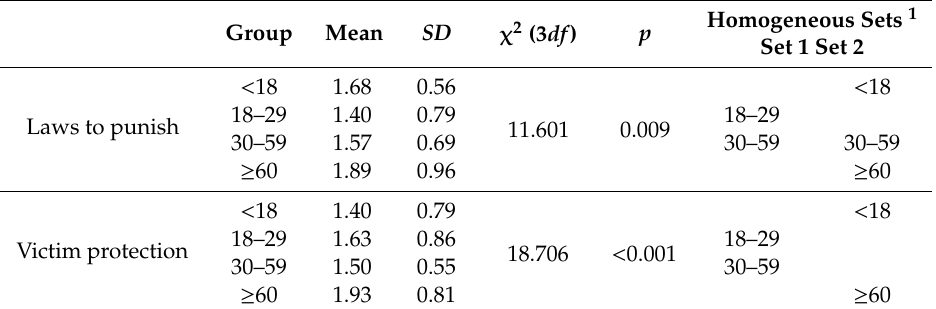
Table 7. Perception about measures for protecting victims and punishing abusers: mean differences among age groups.